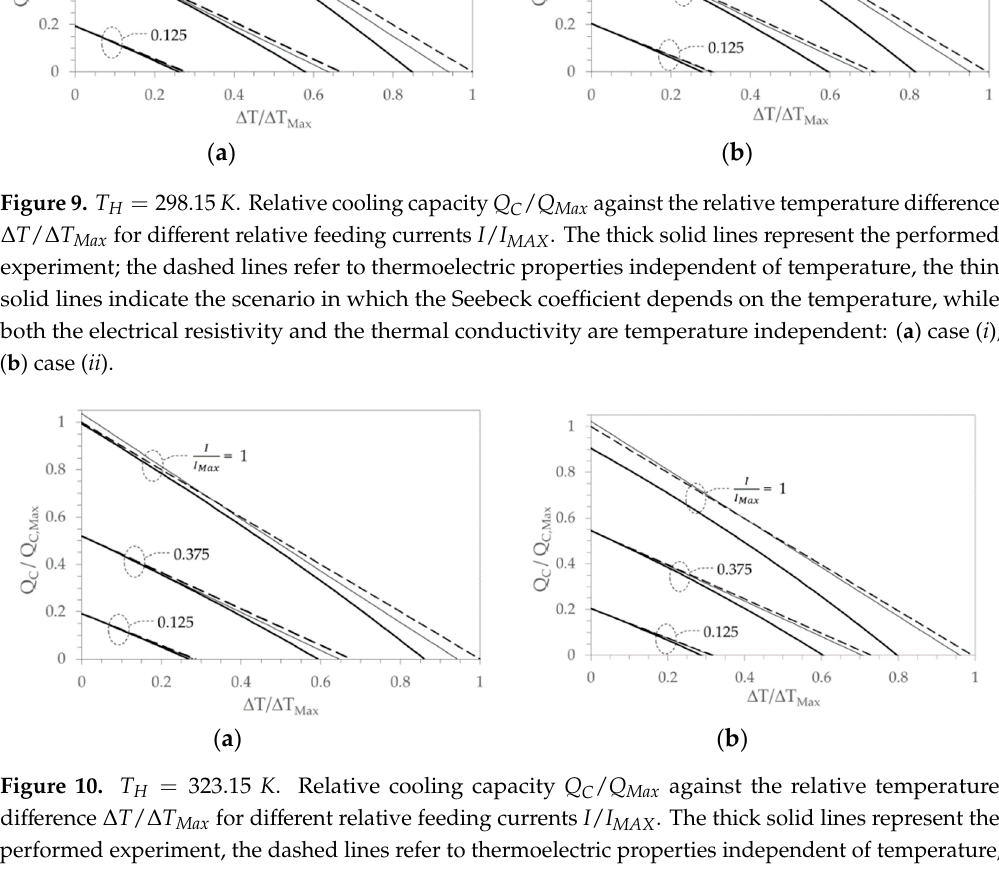
(cid:4670)𝜀 (cid:4671)/Q −2𝑁 𝐼 − (𝐴 𝐿⁄ )𝜆 (cid:3017) (cid:3009) (cid:3009) (cid:3004),(cid:3014)(cid:3028)(cid:3051) , and reproduces the typical trend proposed in datasheets of commercial